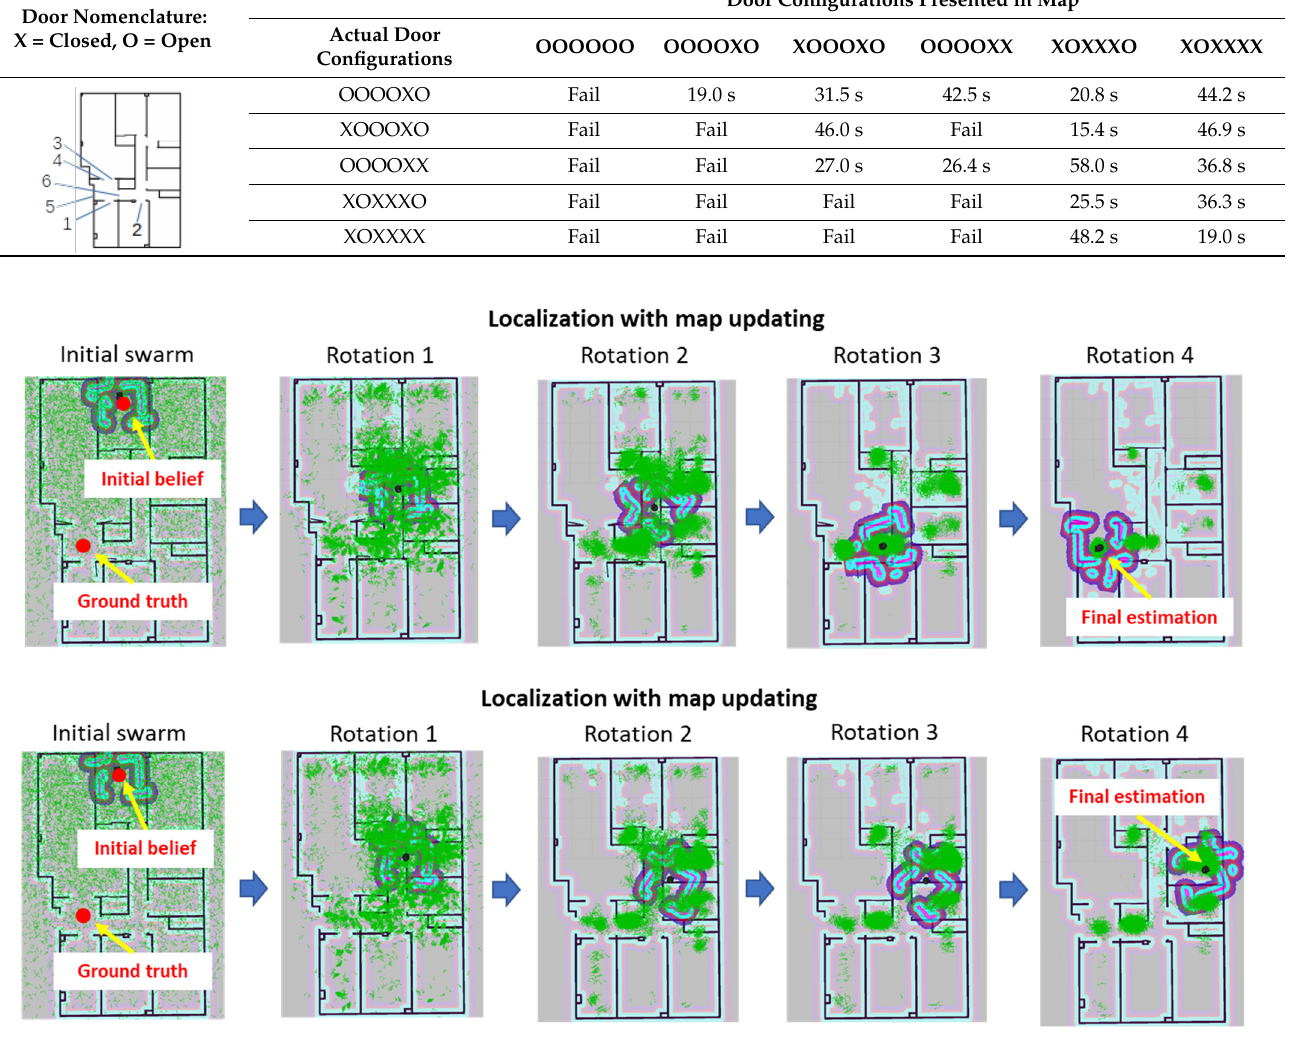
Table 4. Results of localization at stations 2–6, with the average time in seconds before accurate localization. Original Map